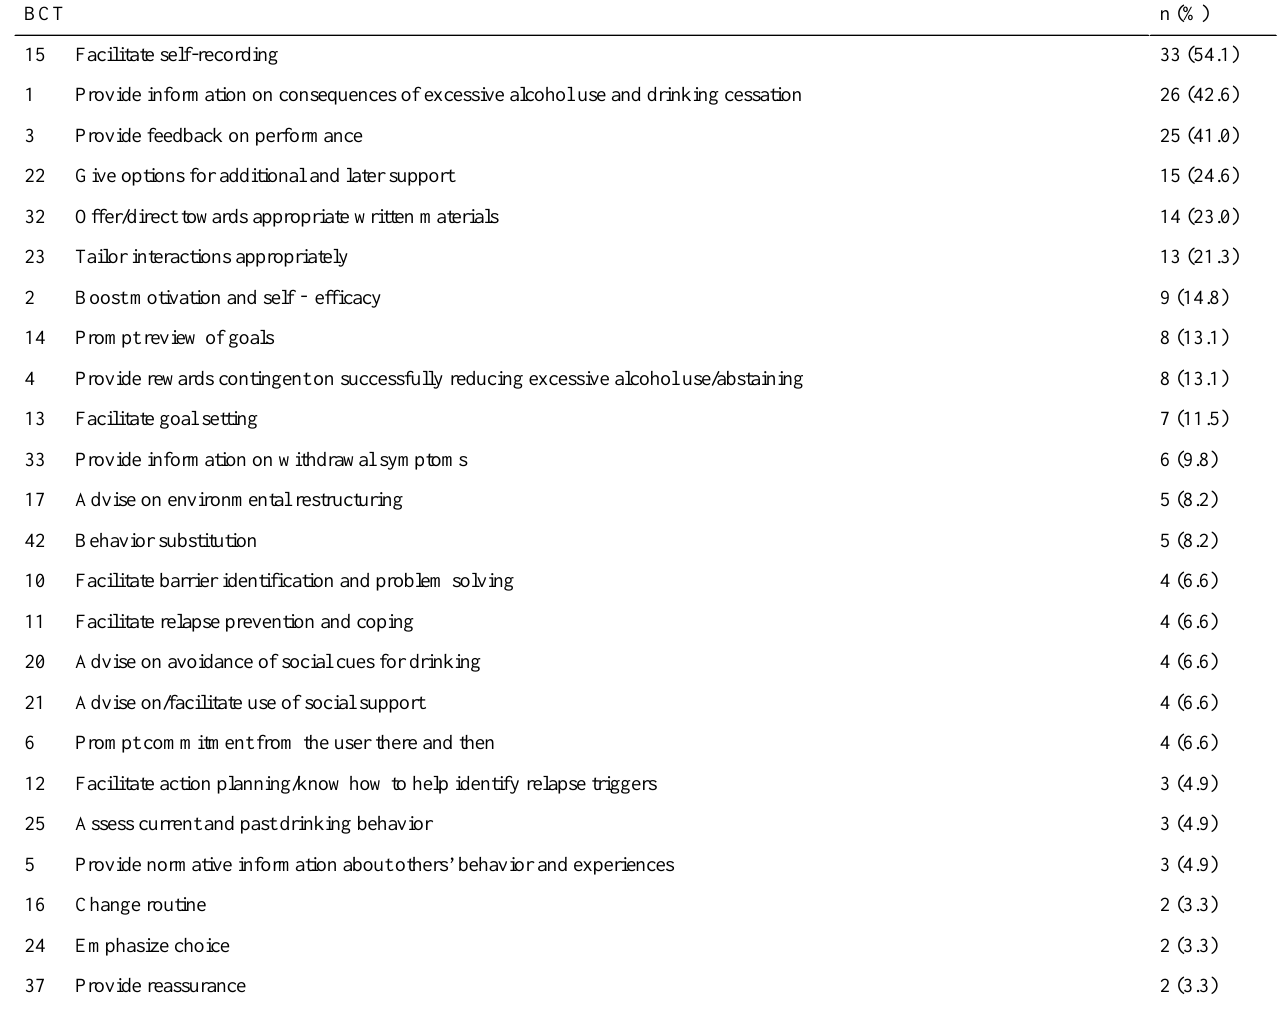
Table 1. BCTs included in alcohol reduction apps (N=61